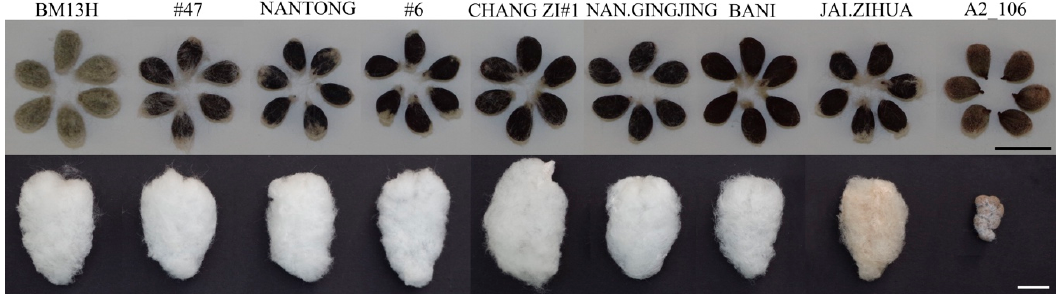
Figure 1. Seed and fibre phenotype of G. arboreum accessions used in this study. Lower panel